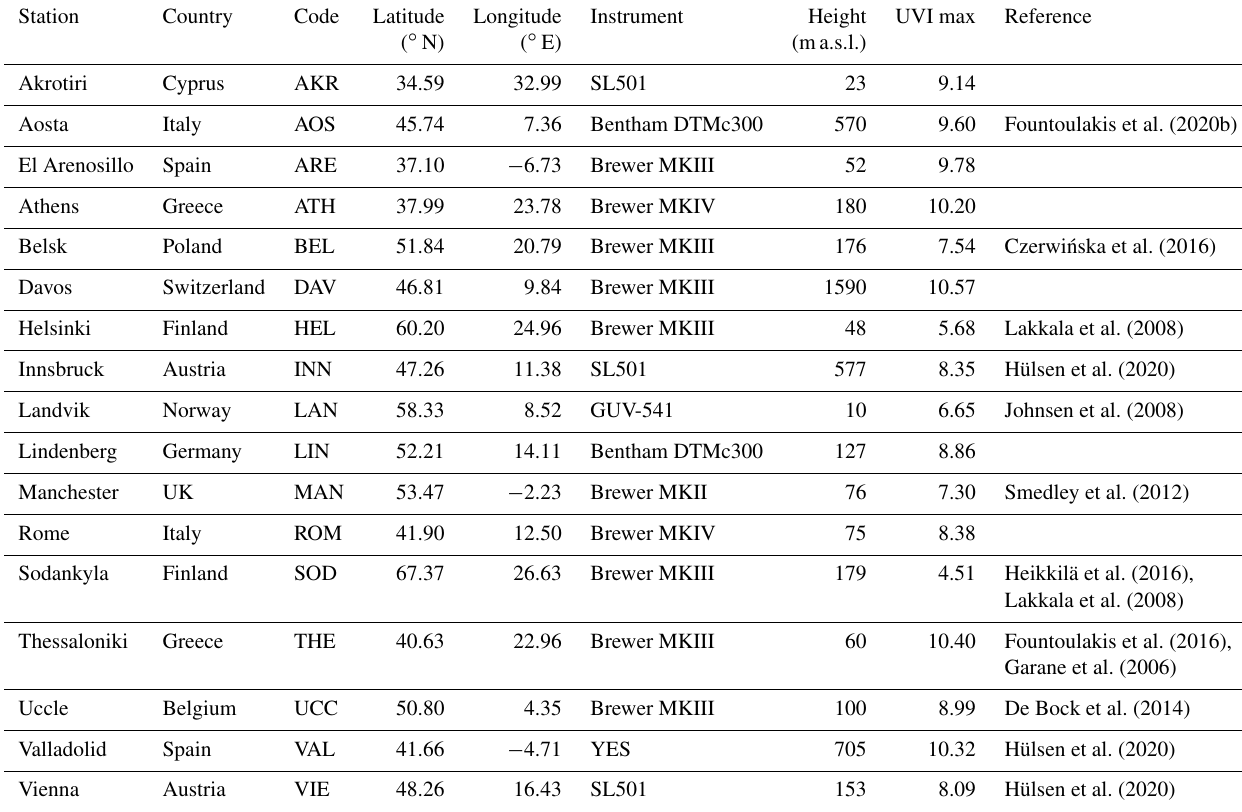
Table 2. Coordinates (degrees), instrument type, height (meters above sea level) and maximum UVI-measured levels of the European stations used for the